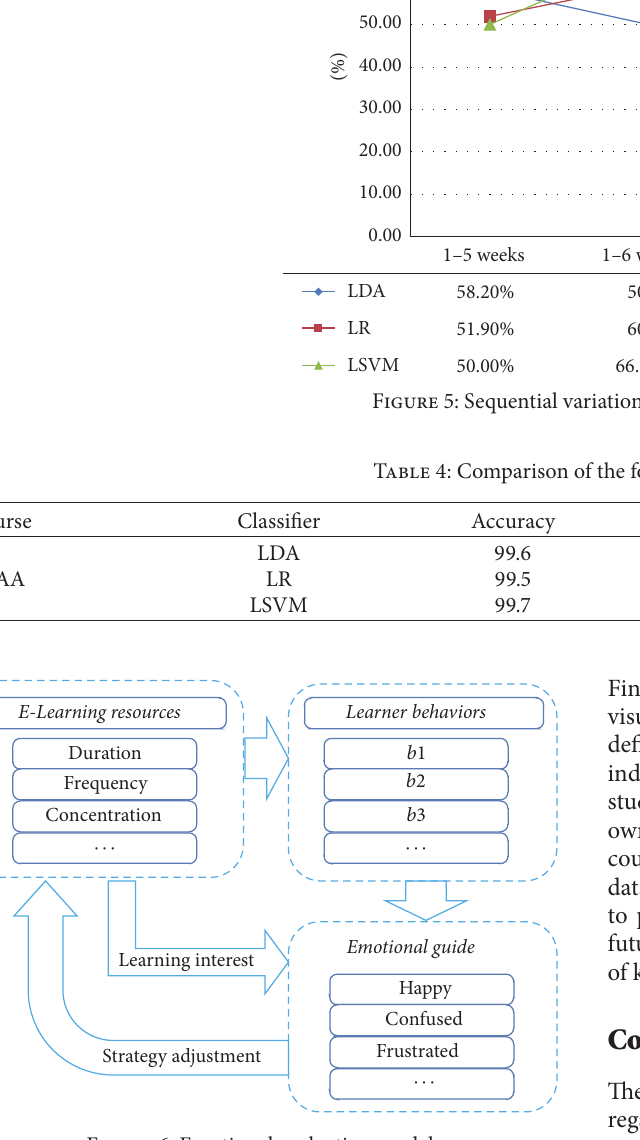
Figure 6: Emotional evaluation